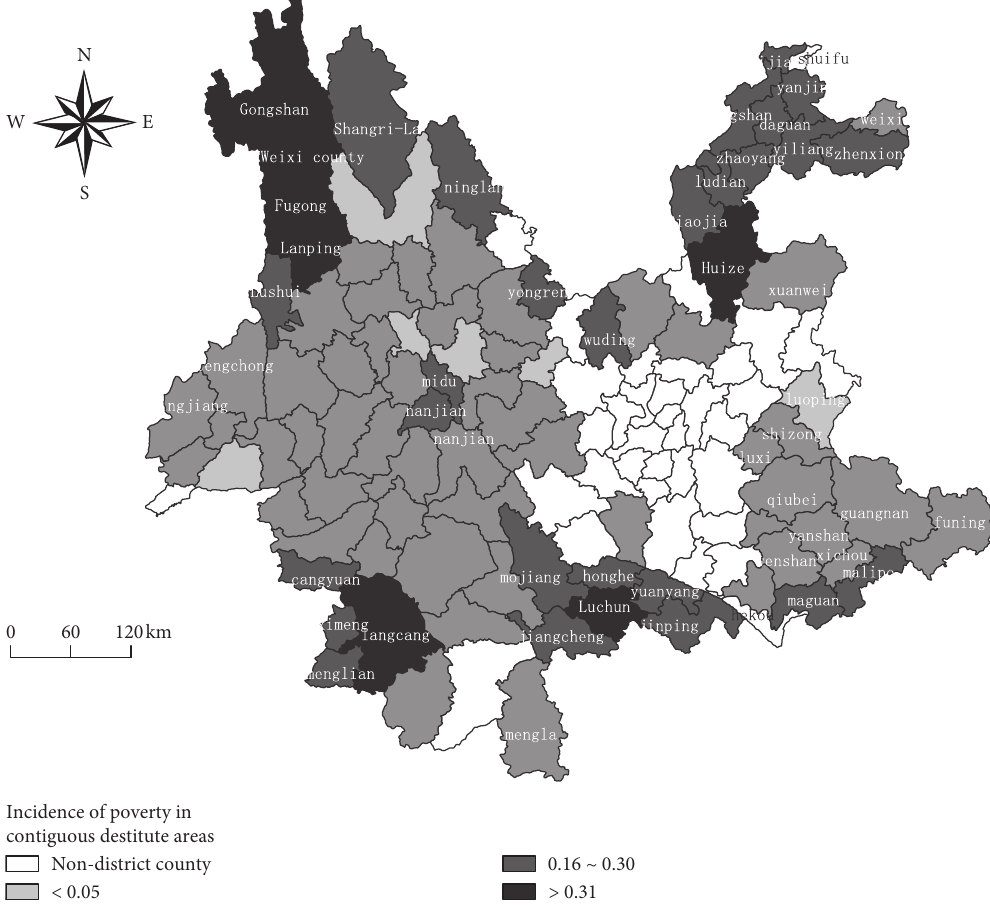
Figure 4: Spatial distribution of poverty rate.